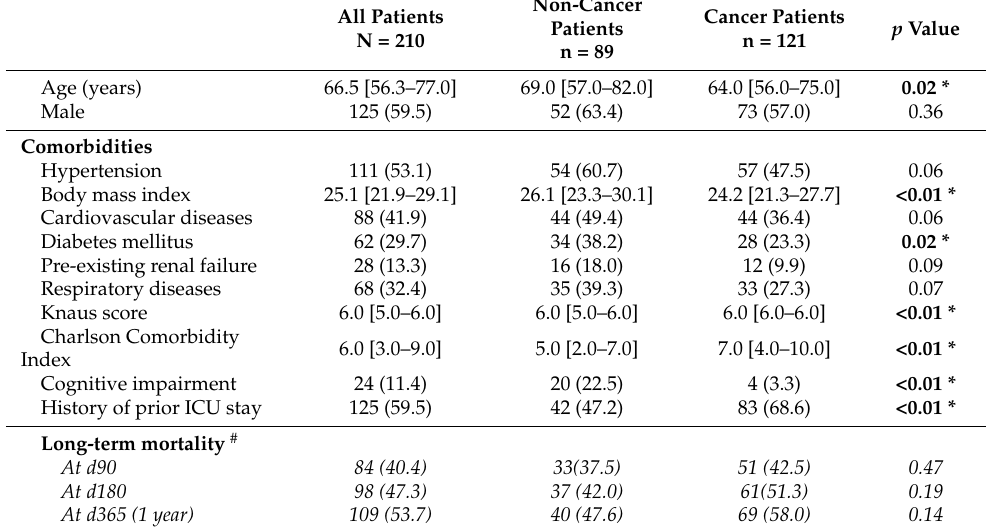
Table 1. Baseline characteristics of septic shock patients.